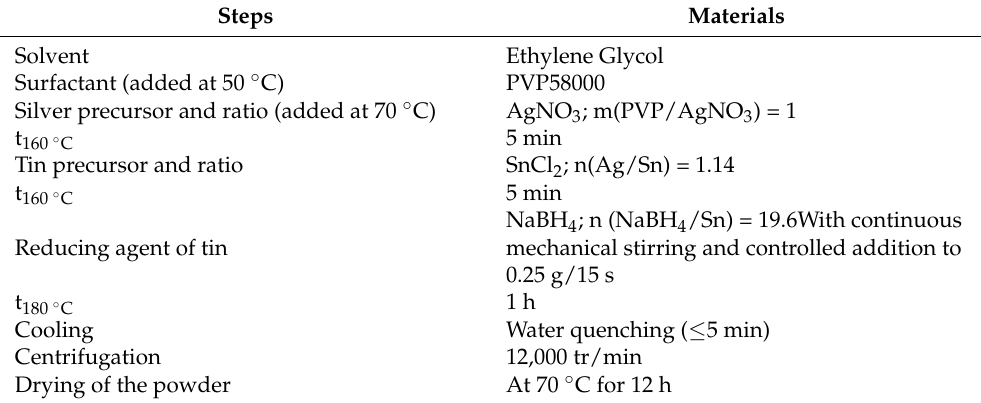
Table 1. Protocol of the synthesis of ζ -Ag 5 Sn 0.9 particles in polyol